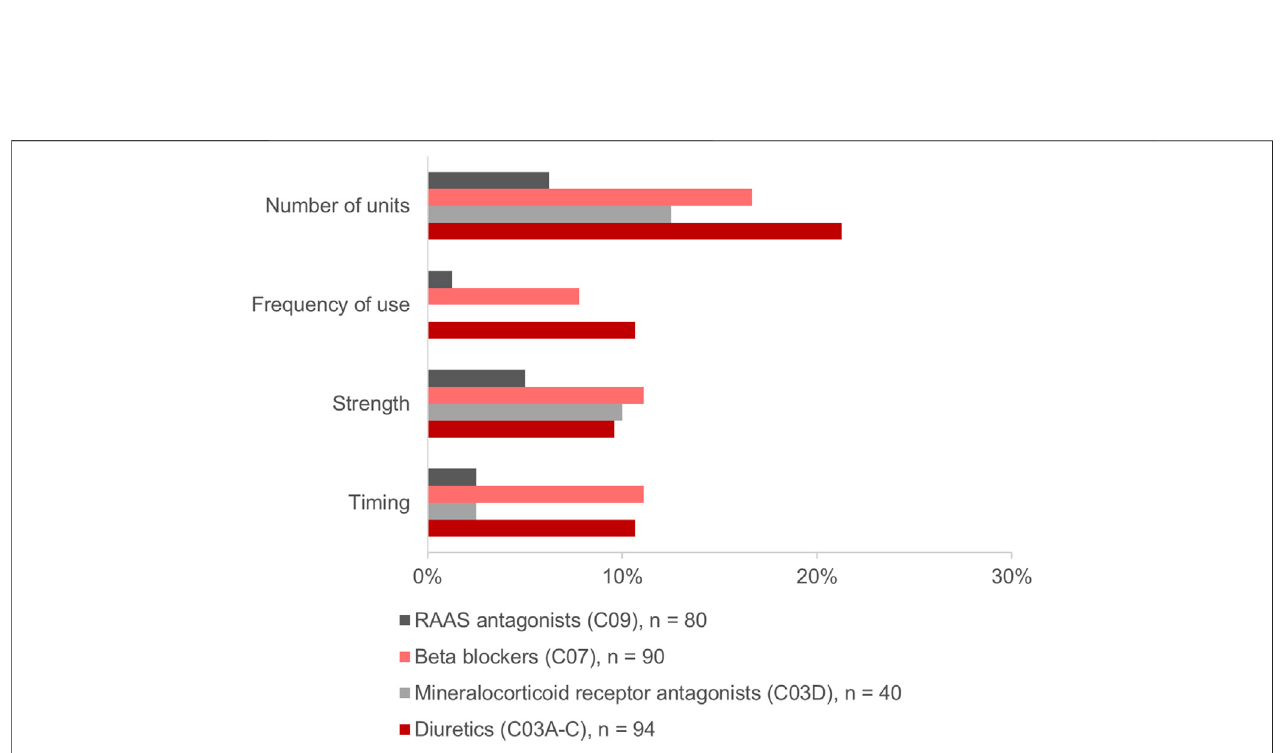
FIGURE 4 | (A) Impact of the interdisciplinary consolidation on the heart failure medication ( n (cid:1) 304 drugs). (B) Changes in the heart failure medication ( n (cid:1) 92 drugs). Variations in the percentages are due to rounding deviations in values.